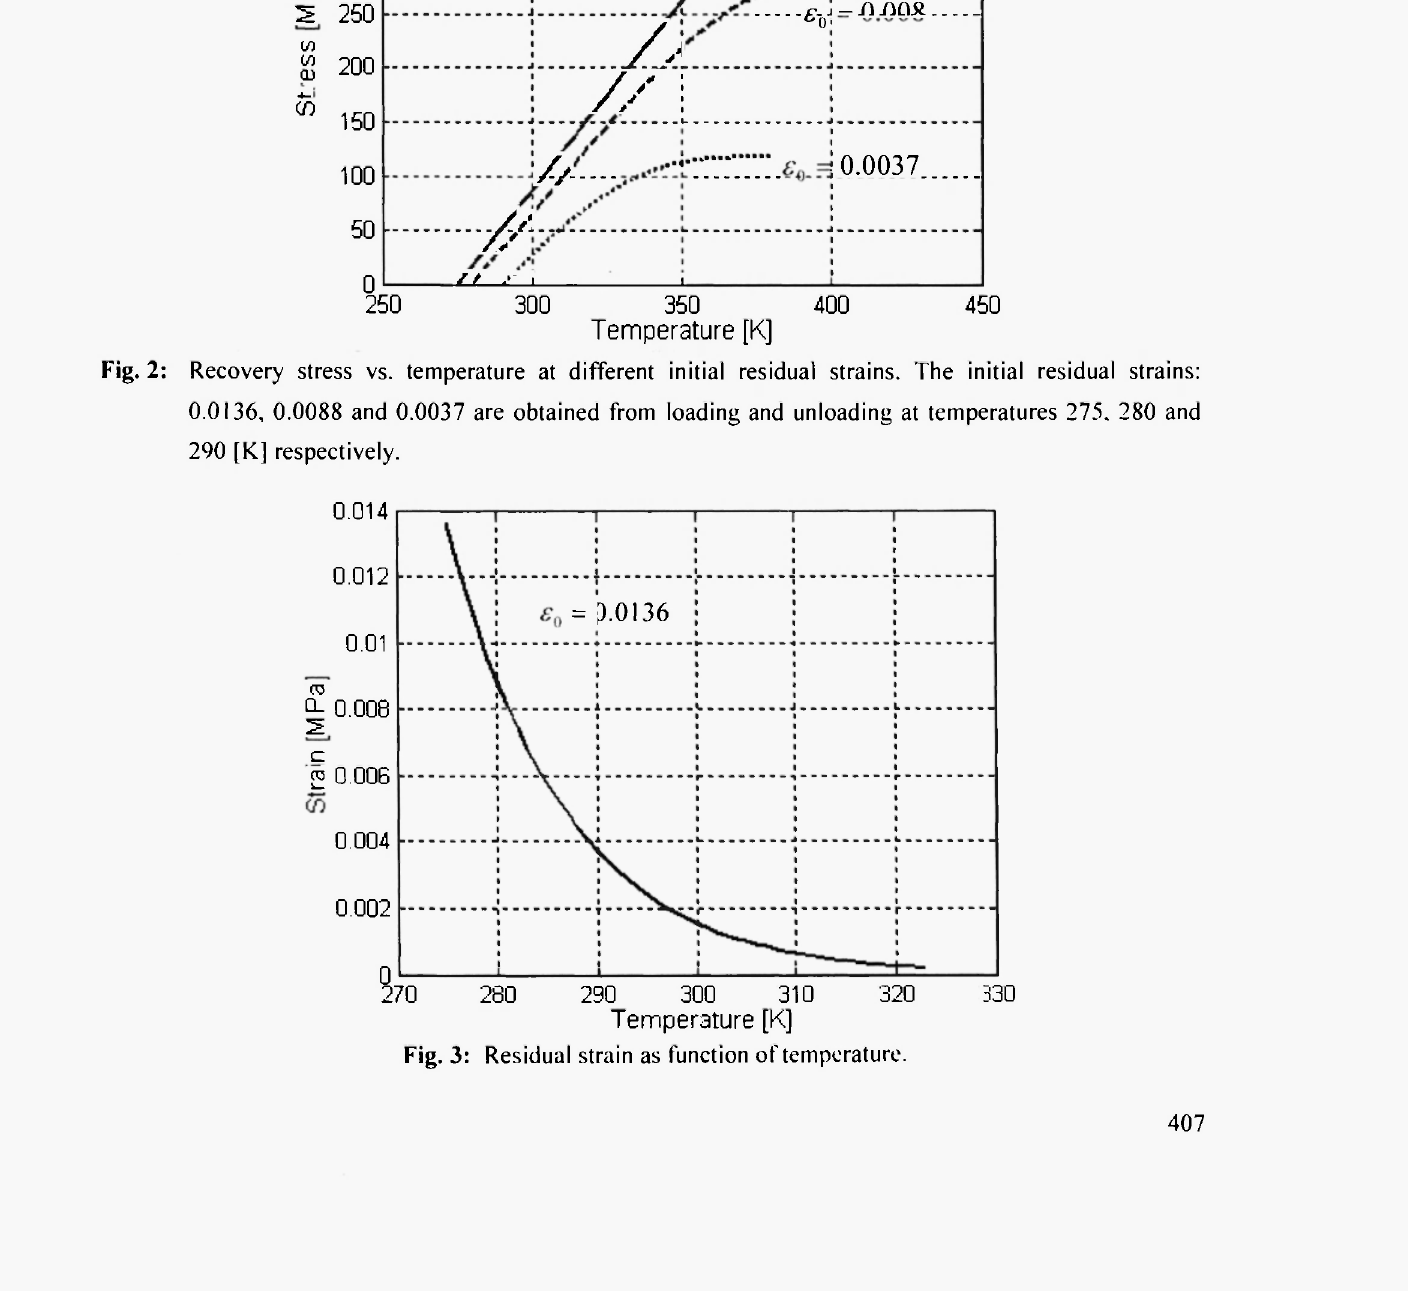
Fig. 3: Residual strain as function of